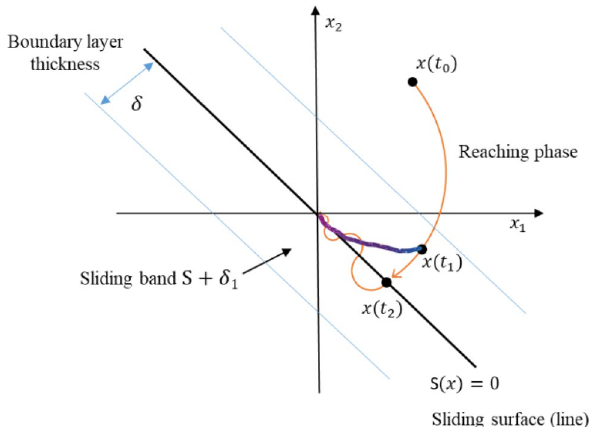
Figure 2. System states (red for classical SMC and red + blue for DSMC).